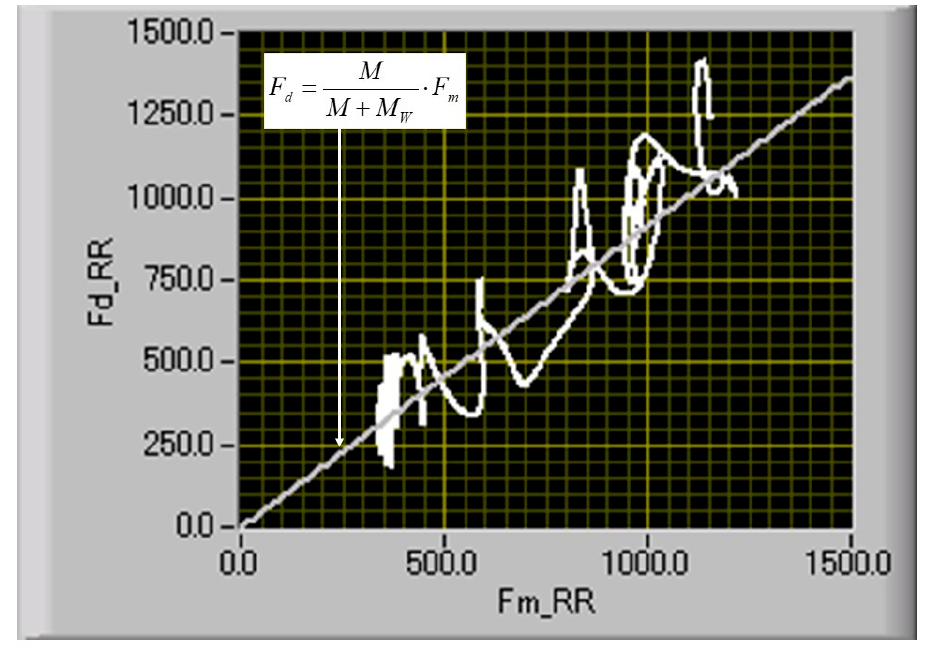
Figure 7. Relationship between friction force, F d_RR , and motor torque, F m_RR , just before the spinout in the accelerated turning test.